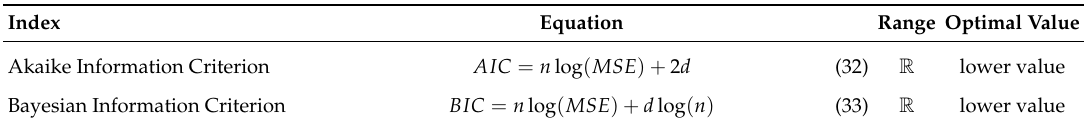
Table 6. Comparison model measures. In the equations, d represents the number of parameters of the